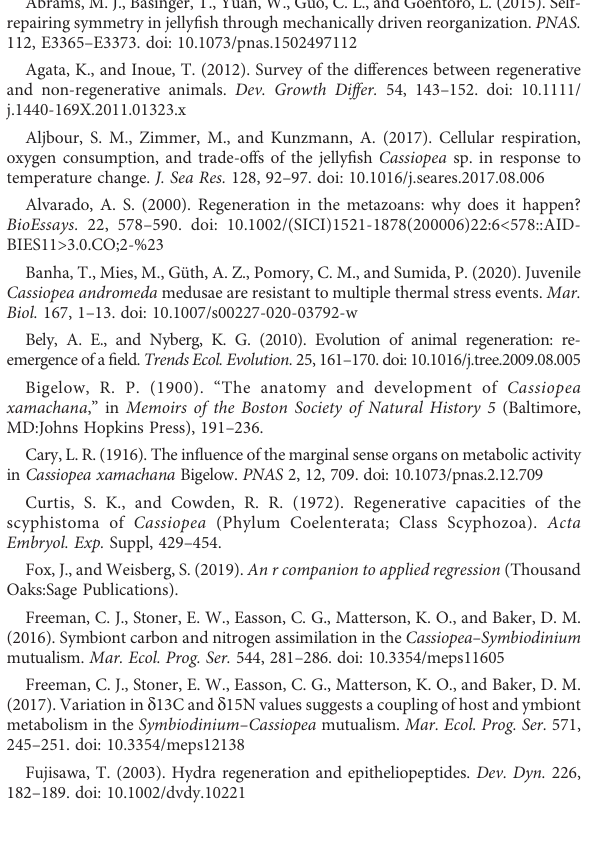
SUPPLEMENTARY TABLE 3 Average Pulsation Rate.